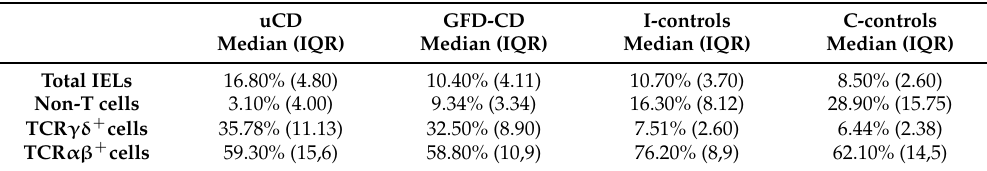
Table 3. Specificity of intraepithelial lymphocytes profiling in the diagnosis of celiac disease.